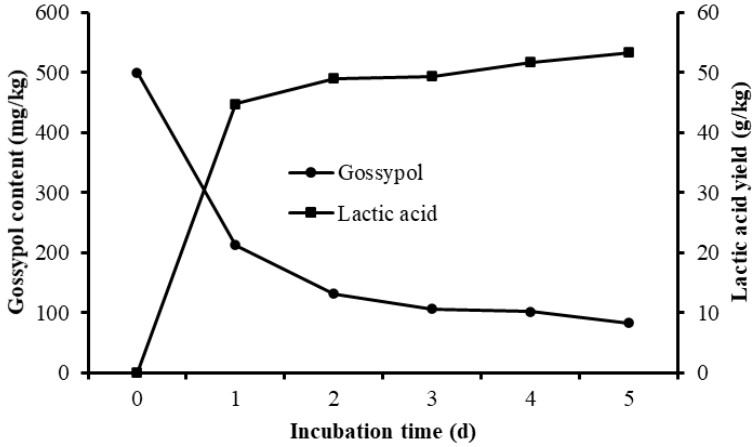
Figure 6. Gossypol content and lactic acid yield of cottonseed meal fermented by L. agilis WWK129. Table 1. Nutritive value of cottonseed meal fermented by L. agilis WWK129 (%, DM).